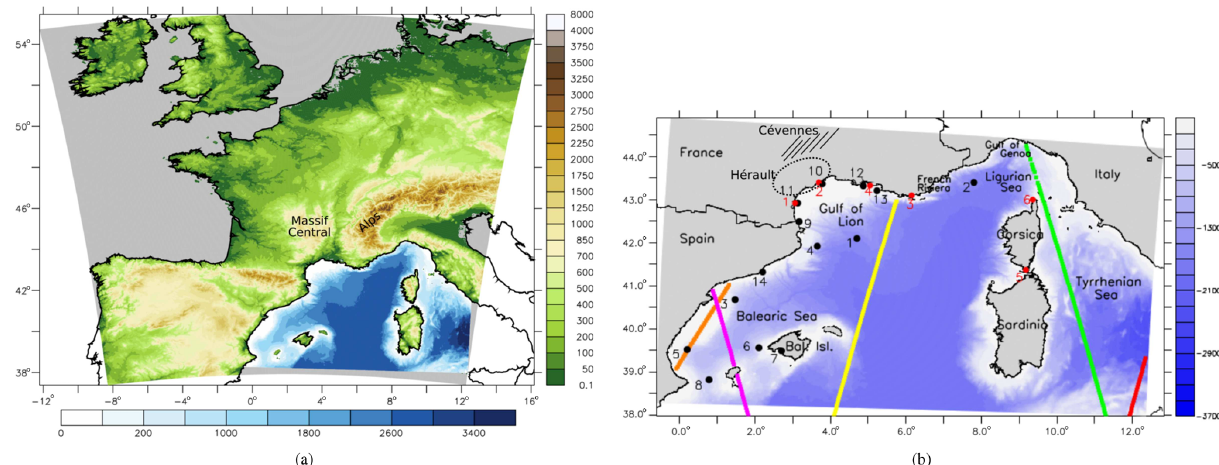
Figure 1. Simulation domain: (a) AROME-France (topography, m) and (b) the WW3 domain illustrated with bathymetry (blue scale, m). Black circles indicate the locations of the moored buoys, and red circles denote the locations of the surface stations (see Table 1). The satellite track around 05:00UTC on 12 October is shown in green, the satellite track around 18:00UTC on 13 October is shown in yellow, the satellite track around 05:00UTC on 14 October is shown in magenta and the satellite track around 18:00UTC on 14 October is shown in red and orange – the orange track is for JASON-2 and the other tracks are for